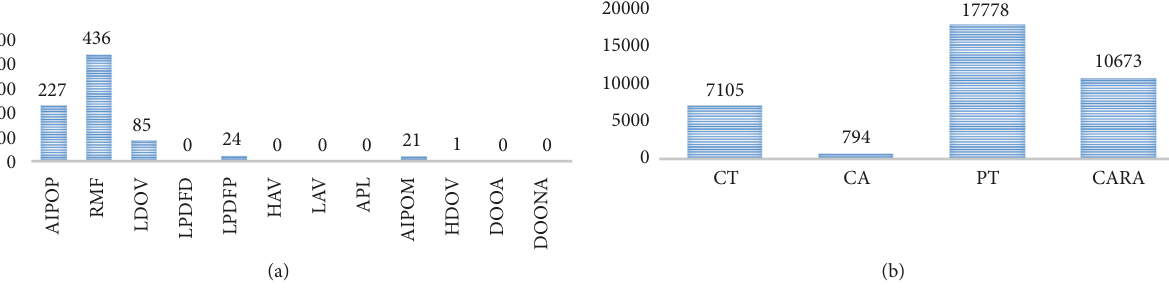
Figure 7: (a) is the occurring alarm number of the different CAs. (b) is the number of CT, CA, PT, and CARA.